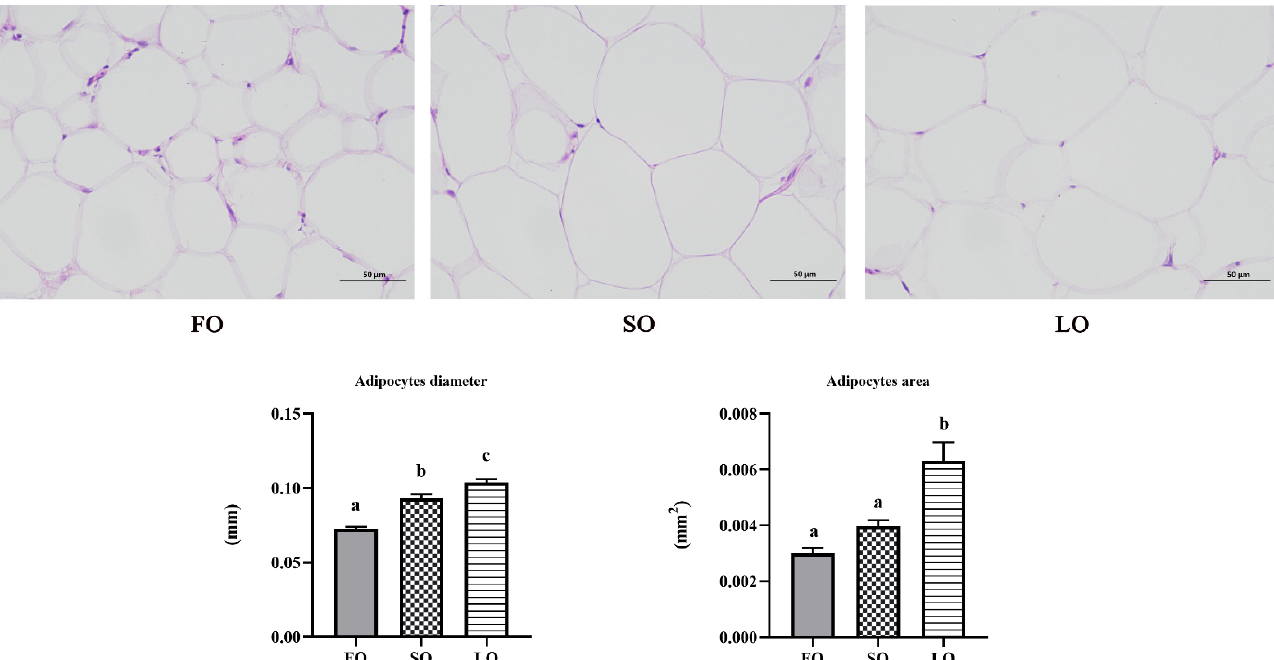
Figure 2. H&E staining and the average diameter and area of adipocytes in adipose tissue of large yellow croaker fed SO and LO diets. Scale bars, 50 μ m. Five adipocytes per slice were selected for measurement (n = 15). Results are presented as the means ± S.E.M. and were analyzed using Tukey’s test. Bars labeled with the same letters are not significantly different ( p > 0.05).